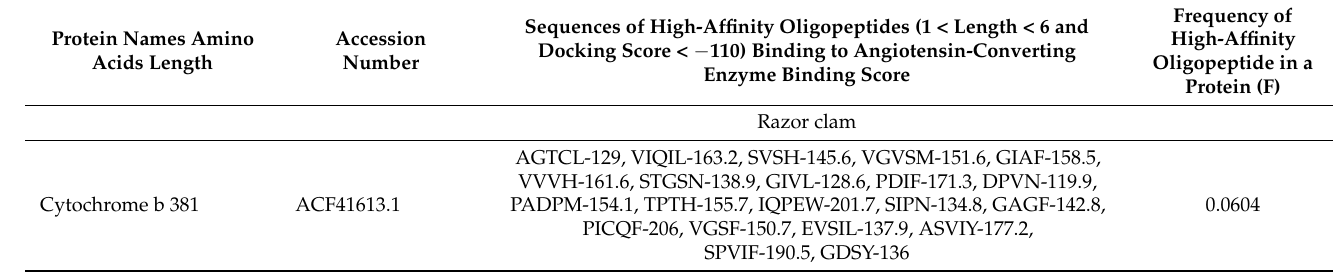
Table 1. Sequences and frequencies of high-affinity oligopeptides binding to angiotensin-converting enzyme from marine shellfish proteins digested in silico by gastrointestinal enzymes.